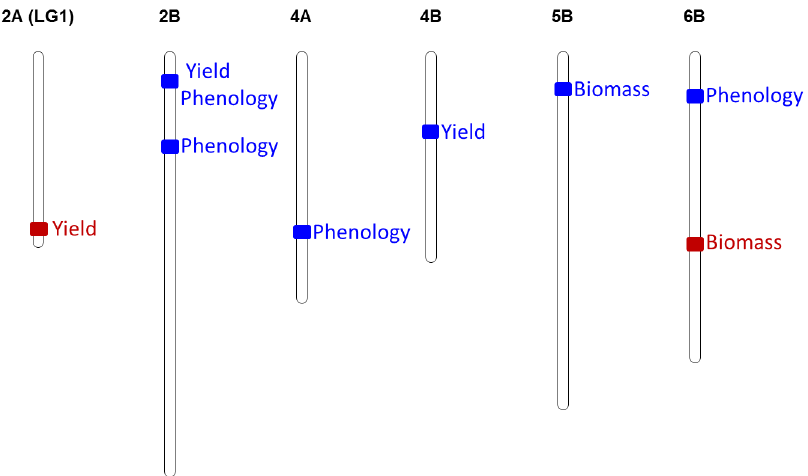
Fig 2. Specific MTAs for north and south. Genomic regionsshowingspecific MTAs for the north (blue) or the south